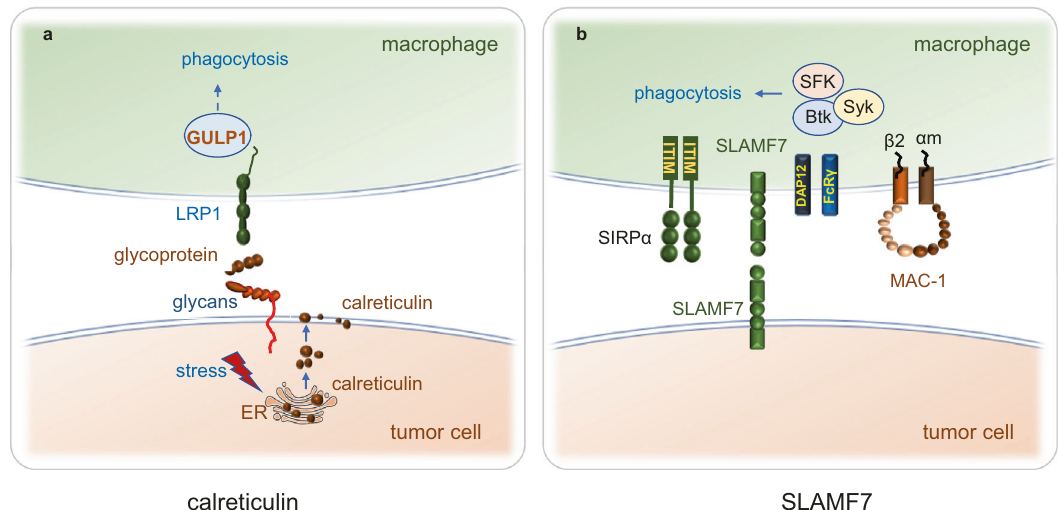
Fig. 4 The “ eat me ” signals calreticulin and SLAMF7. a Stressed and dying tumor cells expose calreticulin on the surface of the cell from ER, and cell surface calreticulin binds to LRP1 on the phagocyte. LRP1 may recruit GULP1, an adapter protein LRP1 for regulating further phagocytic processes. b SLAMF7 on macrophage binds to MAC-1 on the macrophage, and MAC-1 interacts with FCR γ and DAP12 recruiting Src family Syk, and Btk kinases and promoting phagocytosis. SLAMF7 on macrophages combining with SIRP α on macrophage may affect the CD47-SIRP α axis, SLAMF7 in hematological cancers binds SLAMF7 on phagocytes and is necessary for